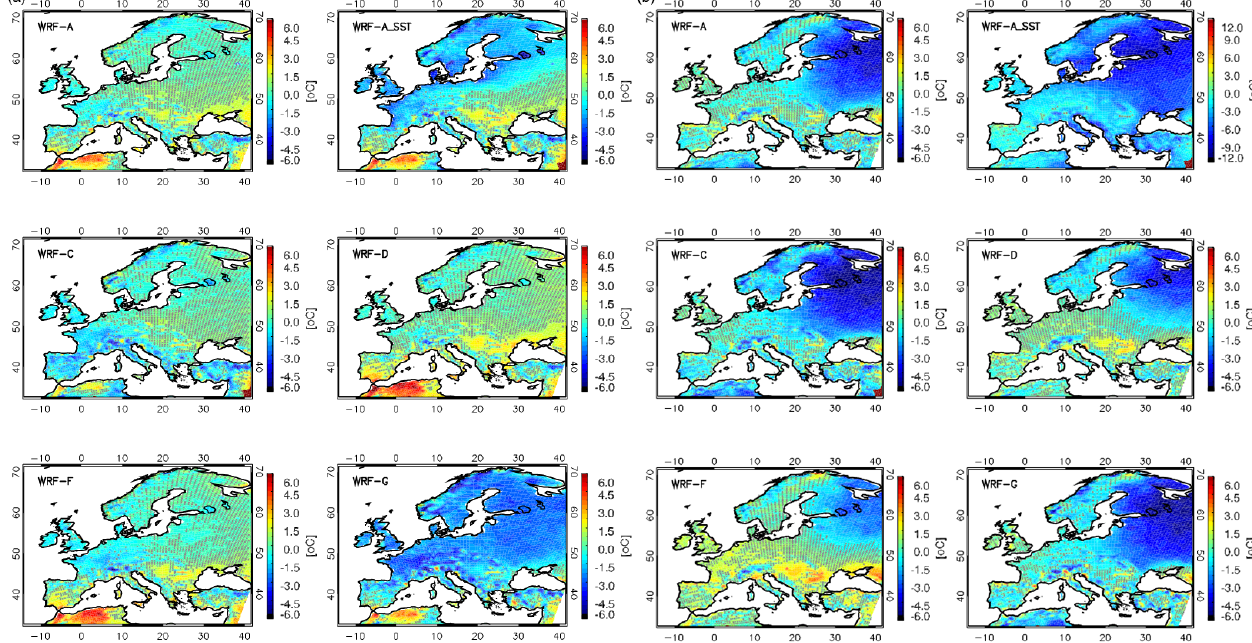
Figure 1. (a) Mean summer and (b) mean winter 1990–2008 surface temperature bias (model-E-OBS9). Stippling indicates areas where the biases are not statistically significant. Mind the differences in colour scales. Table 2a. Means (Mobs) of summer (JJA) surface temperature for observations (E-OBS9) over 1990–2008 in the European subregions and the model mean seasonal bias (Mmod–Mobs). Units are in degrees